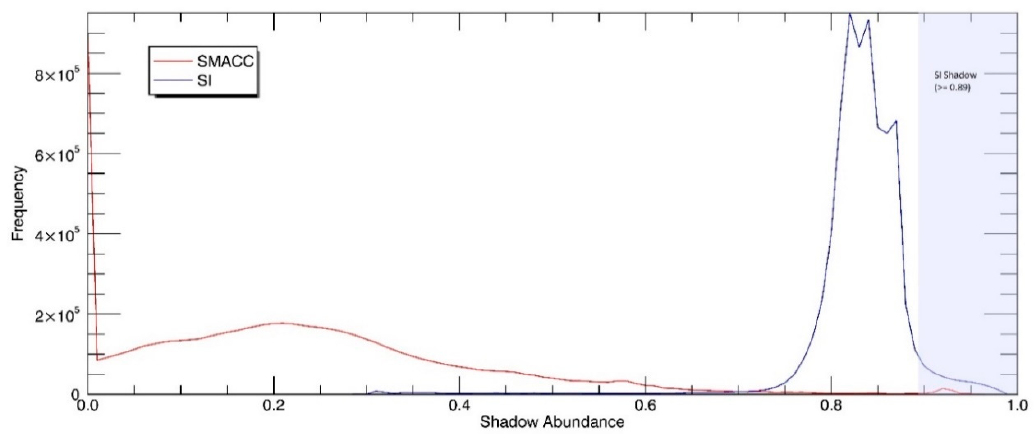
Figure 8. Shadow abundance comparison between SI and SMACC shadow detection methods applied to ADS40 imagery. Shaded area indicates SI threshold range ( ≥ 0.89) for shadow.